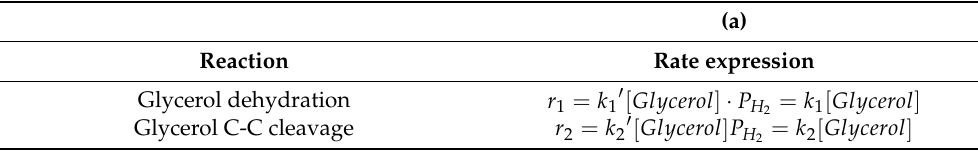
Table A4. (a) Rate expressions for the compounds in a glycerol hydrogenolysis process, (b) Mole balance equation for each